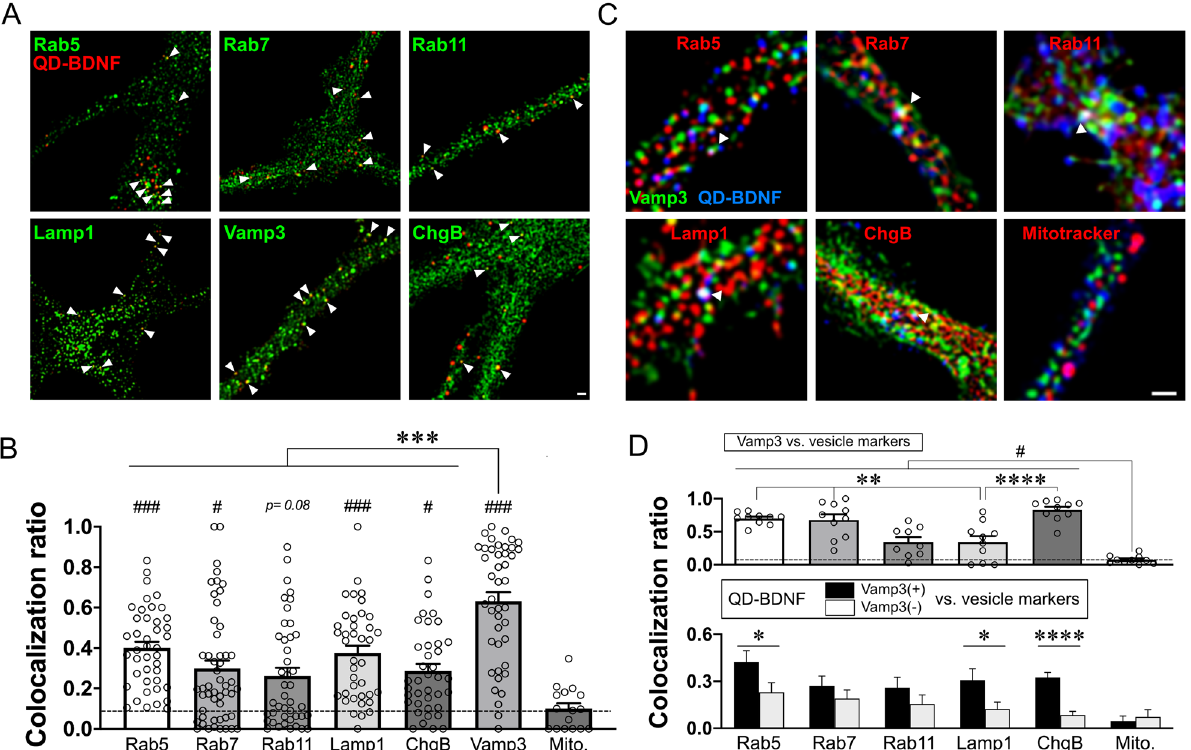
Figure 3. Subcellular localization of endocytic BDNF in cultured astrocytes. (A) Representative fluorescence images of the colocalization of QD-BDNF with endogenous vesicular markers. ChgB: chromograninB. Scale bar = 2 µm. White arrowheads: representative colocalization of QD-BDNF with the corresponding markers. ( B) Average colocalization ratios (# colocalized QD-BDNF/# total QD-BDNF). Dotted line: average colocalization ratio between QD-BDNF and MitoTracker (Mito.; negative control). ** P < 0.01 (Vamp3 vs. others), ## P < 0.01 (Mito. vs. others). N = 39–45 cells (1,834–10,531 QD particles) for vesicular markers. ( C) Representative fluorescence images of the colocalization of QD-BDNF, Vamp3-EGFP, and other vesicular markers. Scale bar = 2 µm. White arrowheads: representative triple colocalization among QD-BDNF, Vamp3-EGFP, and the corresponding vesicular markers. ( D) Above: average colocalization ratio between Vamp3-EGFP and each vesicular marker. * P < 0.05, ** P < 0.01. Below: average colocalization ratio of each vesicular marker with QD-BDNF with Vamp3-EGFP (Vamp3( +)) or without Vamp3-EGFP (Vamp3(−)). ** P < 0.01. N = 9–10 cells (QD-BDNF particles: 124–481; Vamp3-EGFP puncta: 449–626). Colocalization ratios were determined by using ImageJ/FIJI software (Ver. 2.1.0/1.53c, BDNF release, because we observed a significant number of QD-BDNFs localized in the Vamp3 negative vesicles (Fig. 3) and ATP-triggered QD-BDNF release events from Vamp3 (-) vesicles (Fig. 4B). These findings support the notion that astrocytic mBDNF recycling involves multiple but differential signaling pathways. Additional studies will further explore the other aspects of molecular events regulating BDNF recycling in astrocytes and their physiological functions in synaptic plasticity and cognitive functions.